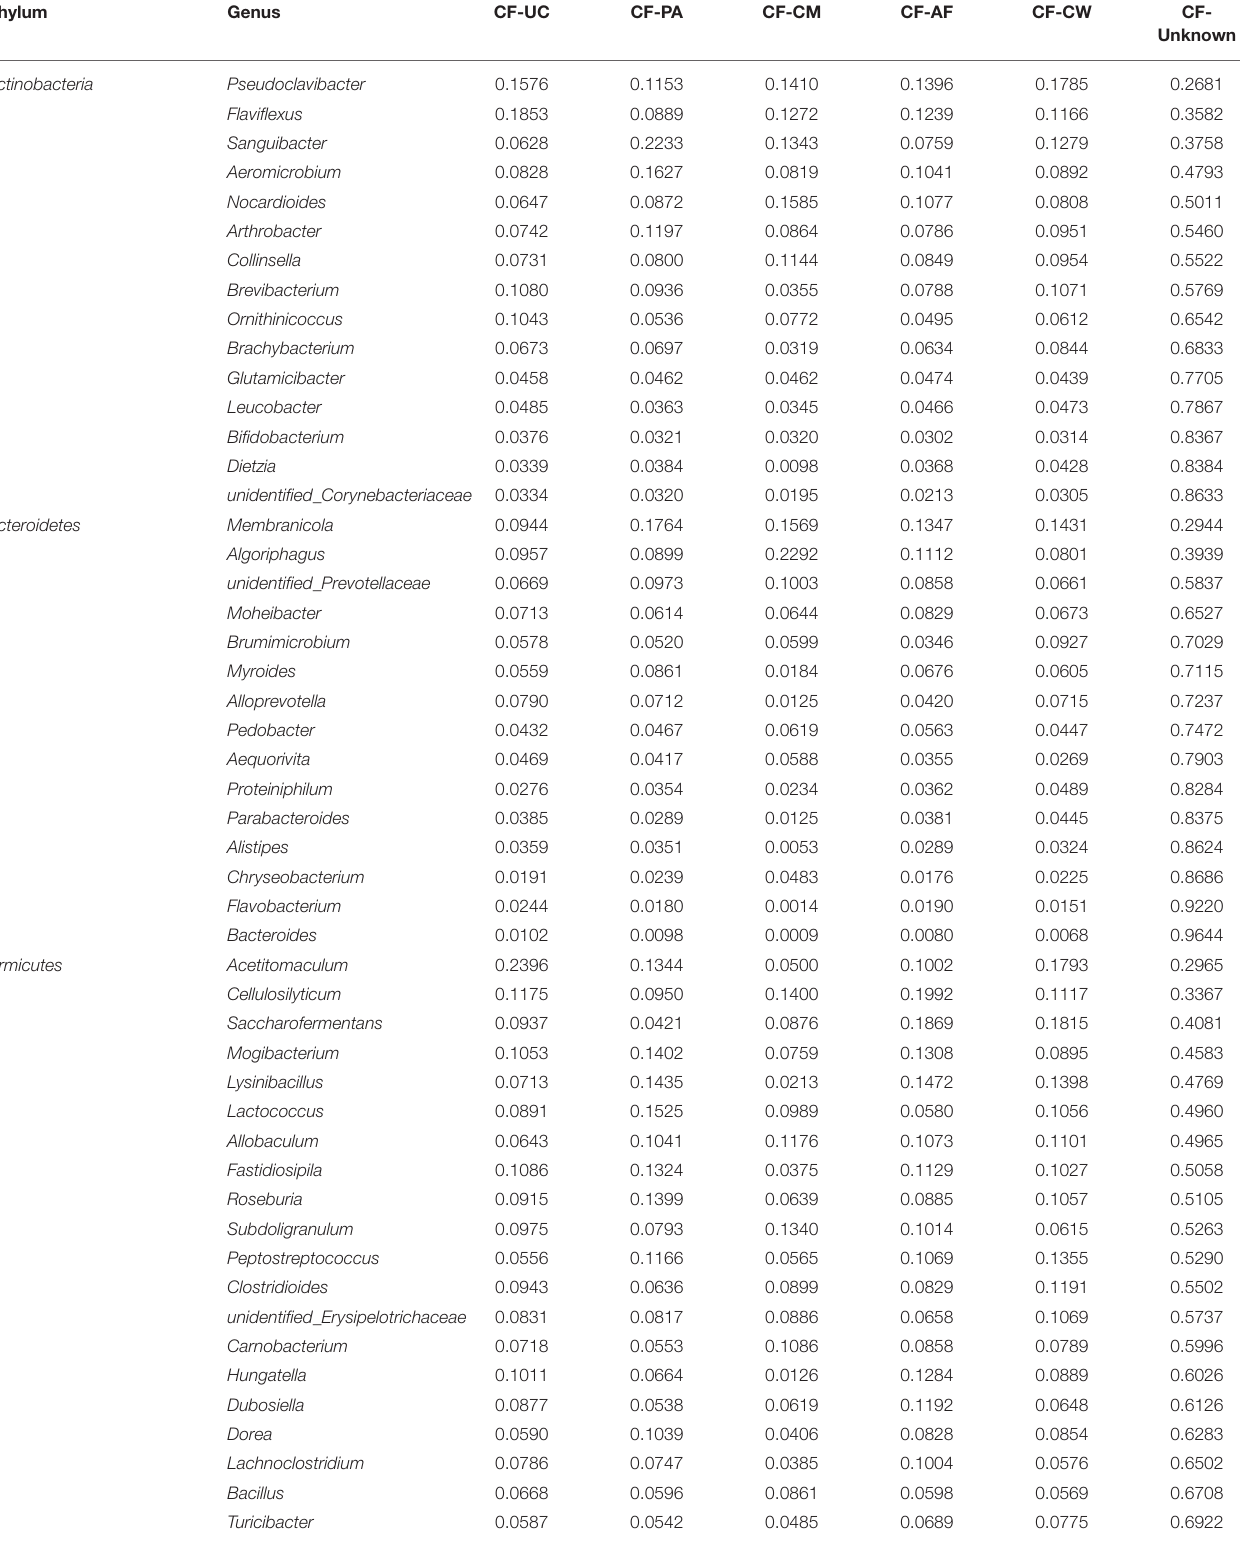
TABLE 5 | Estimation of the matching ratio of meconium to the main genera in each part of their mothers during maternal transmission.